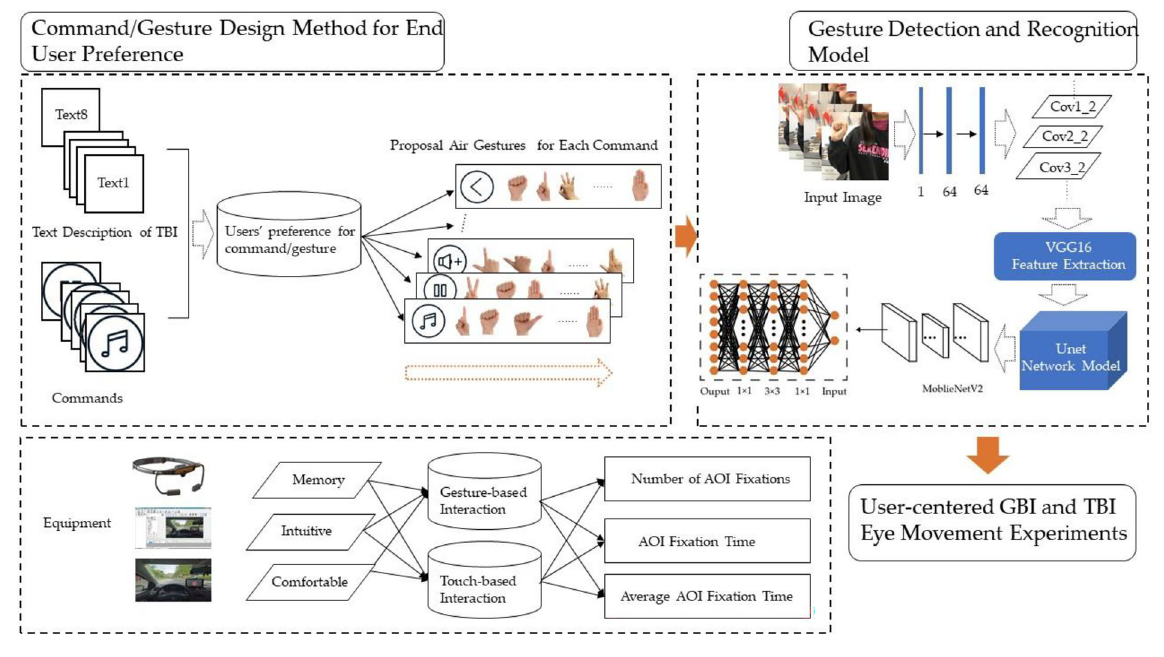
Fig. 1 The overall theoretical framework of this paper